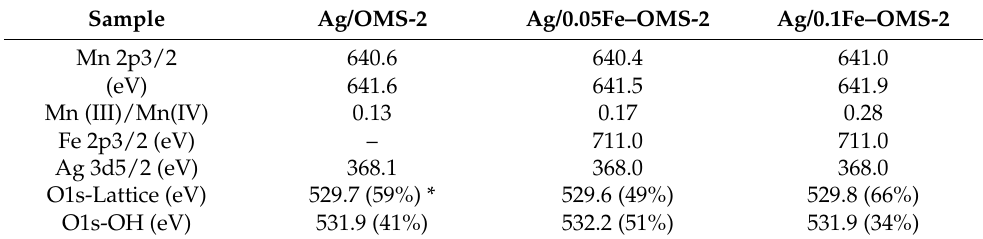
Table 1. XPS data for the prepared